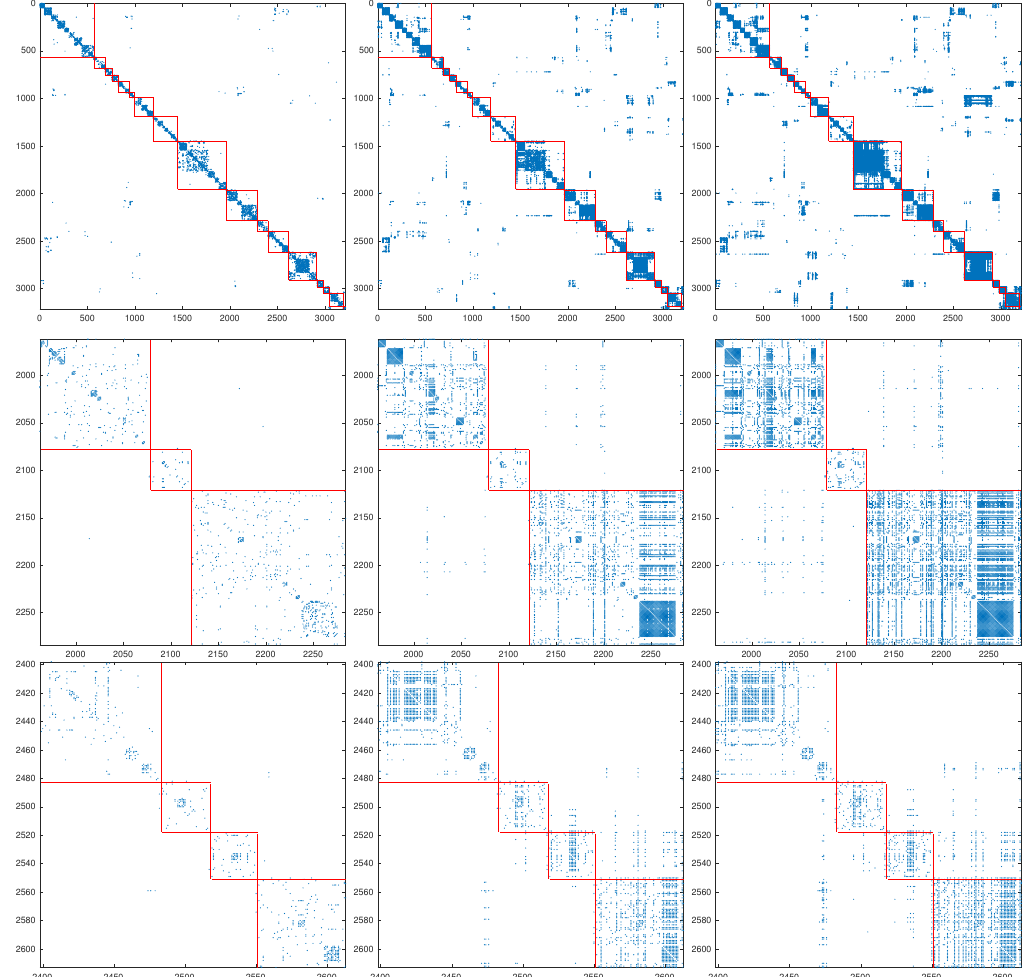
Figure 1. From top to bottom: movements between the 3214 mobility areas organized alphabetically by Autonomous Communities, between the areas of the provinces of Valencia and between the areas of the provinces of Galicia. From left to right: movements between areas of more than 100 people (Spanish National Institute of Statistics (INE) data 1 April), movements between areas obtained with our algorithm from the INE data of April 1 and from the INE data of November. In the two last cases the fluxes are only shown when more than 10 people have moved between